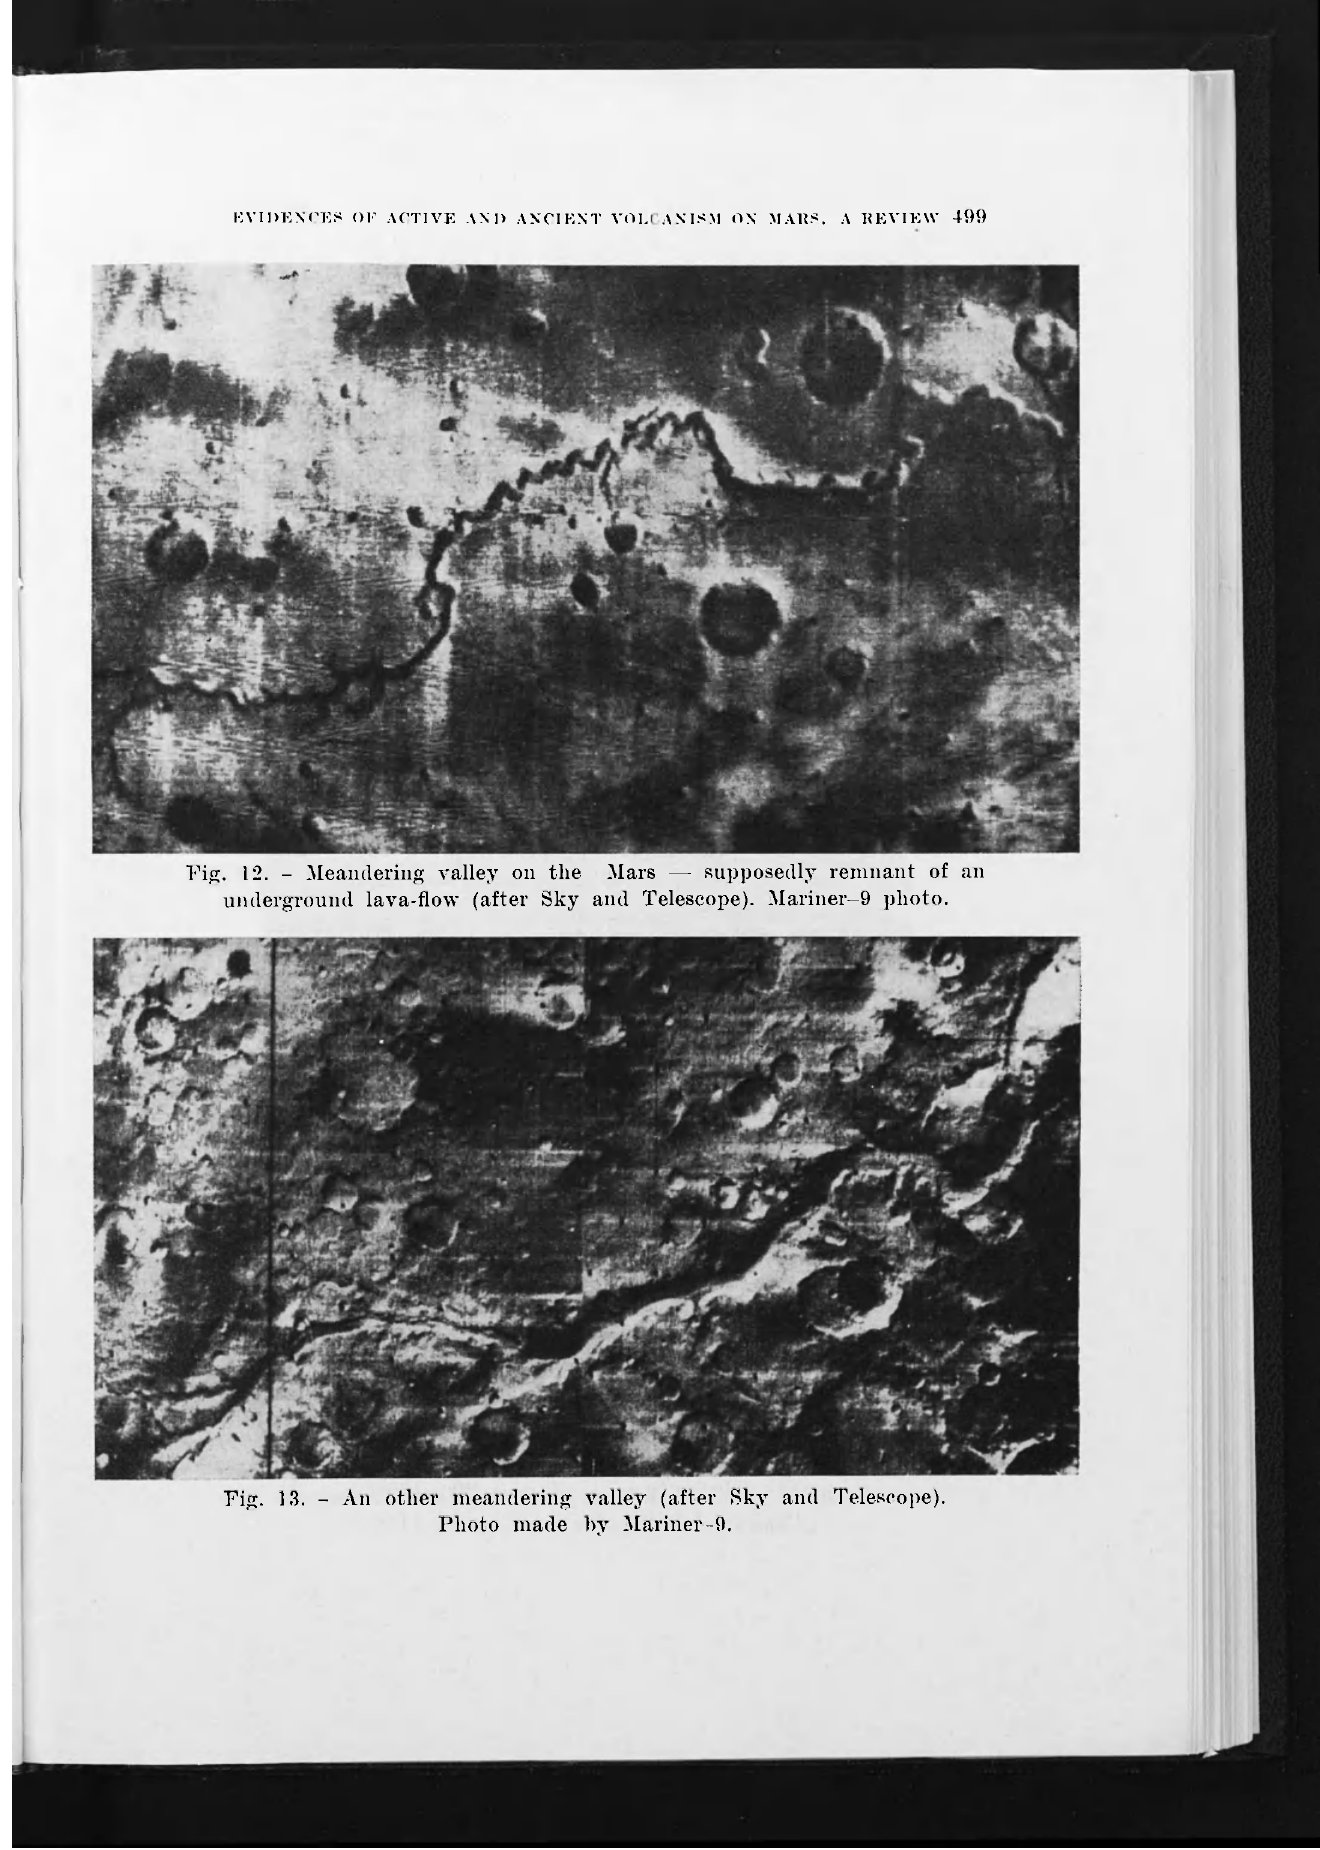
Fig. 13. - An other meandering valley (after Sky and Telescope). Photo made by